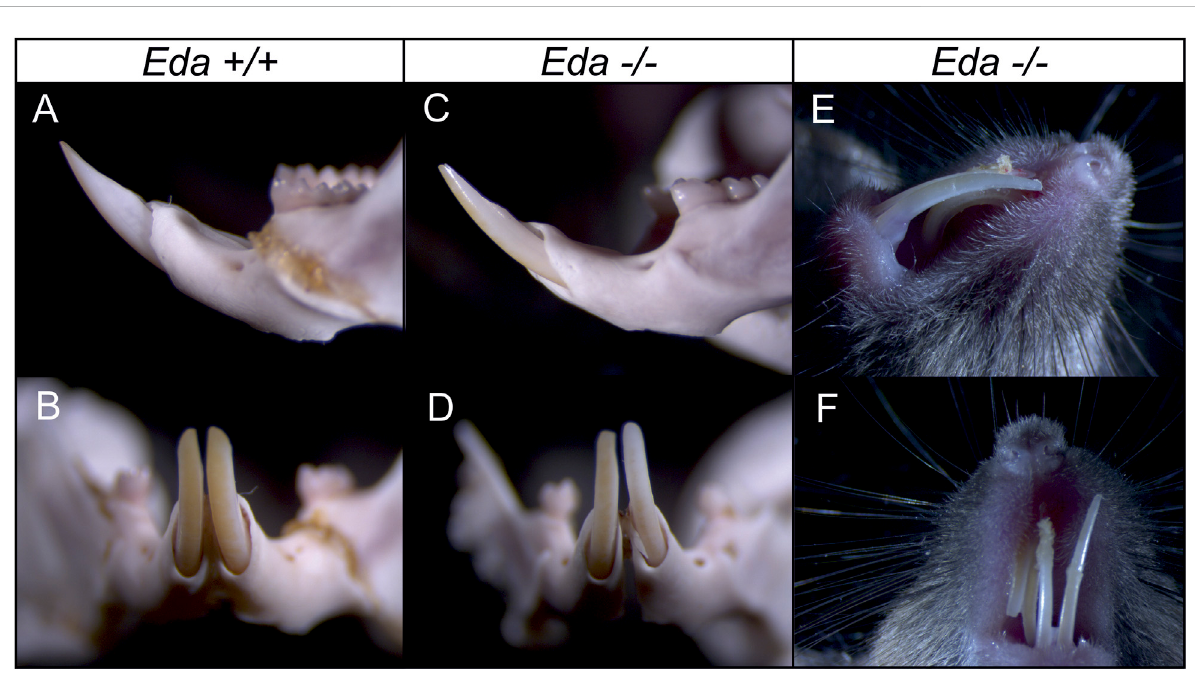
Incisors in the adult control Eda+/+ and Eda − / − mice. Compared to control Eda+/+ mice (A,B) , the erupted incisors in Eda − / − mice show variable phenotype from only slight hypoplasia (C,D) to hypomineralized and hypoplastic incisors (E,F) what fi ts with previous analysis (Miard et al., 1999; Risnes et al.,